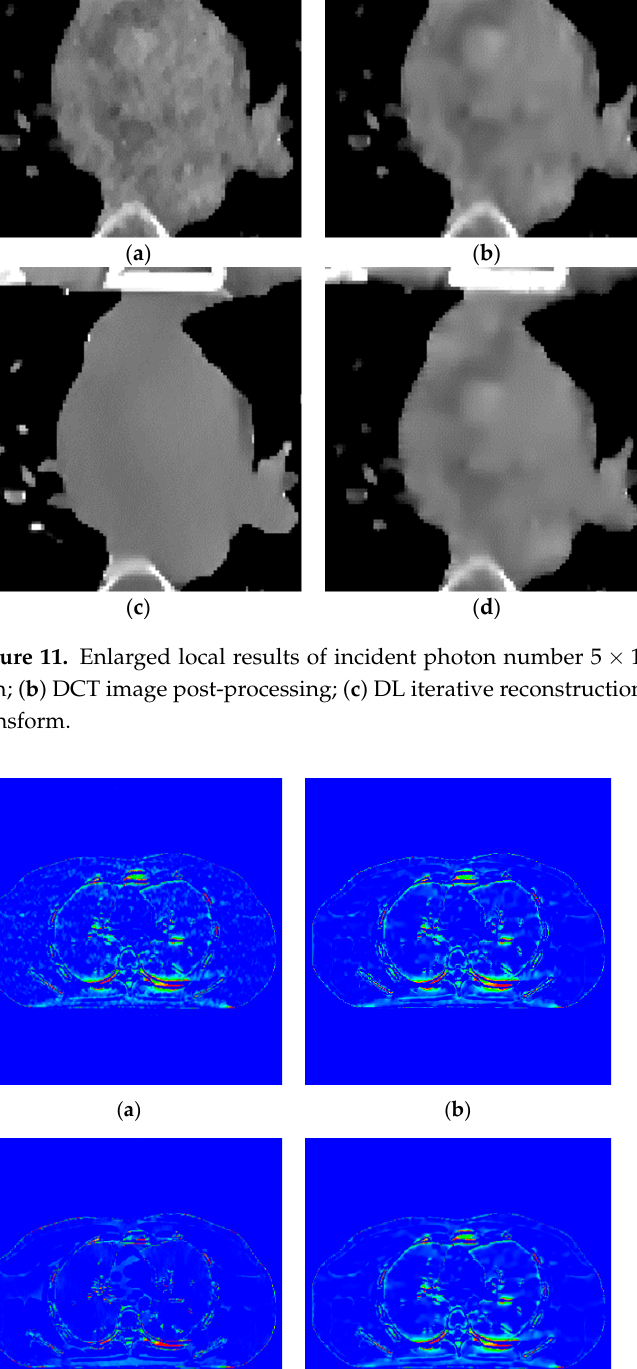
Figure 10. Experimental results of incident photon number 5 × 10 (cid:2871) . ( a ) Real image; ( b ) FBP recon- struction; ( c ) EP iterative reconstruction image; ( d ) DCT image post-processing; ( e ) DL iterative re- construction; ( f ) learning sparse transform.